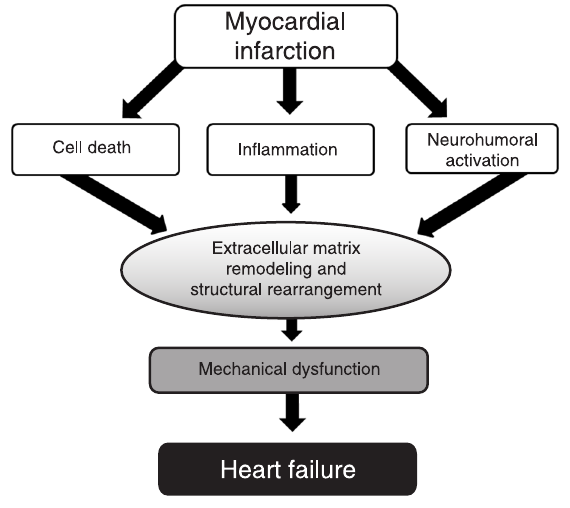
Figure 1. Schematic representation of the time course of post- infarction